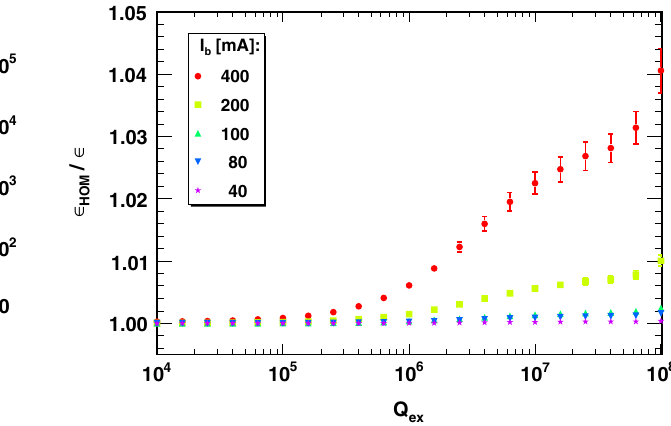
FIG. 8. Average longitudinal phase space increase and devia- i . for different h I tion of 100 linacs against the damping Q b ex i 2 . The plateau around Q (cid:3) 4 (cid:4) =(cid:6) is proportional to h I (cid:6) b HOM ex 10 7 is due to the pulse period structure. Settings: N ¼ 100 ,